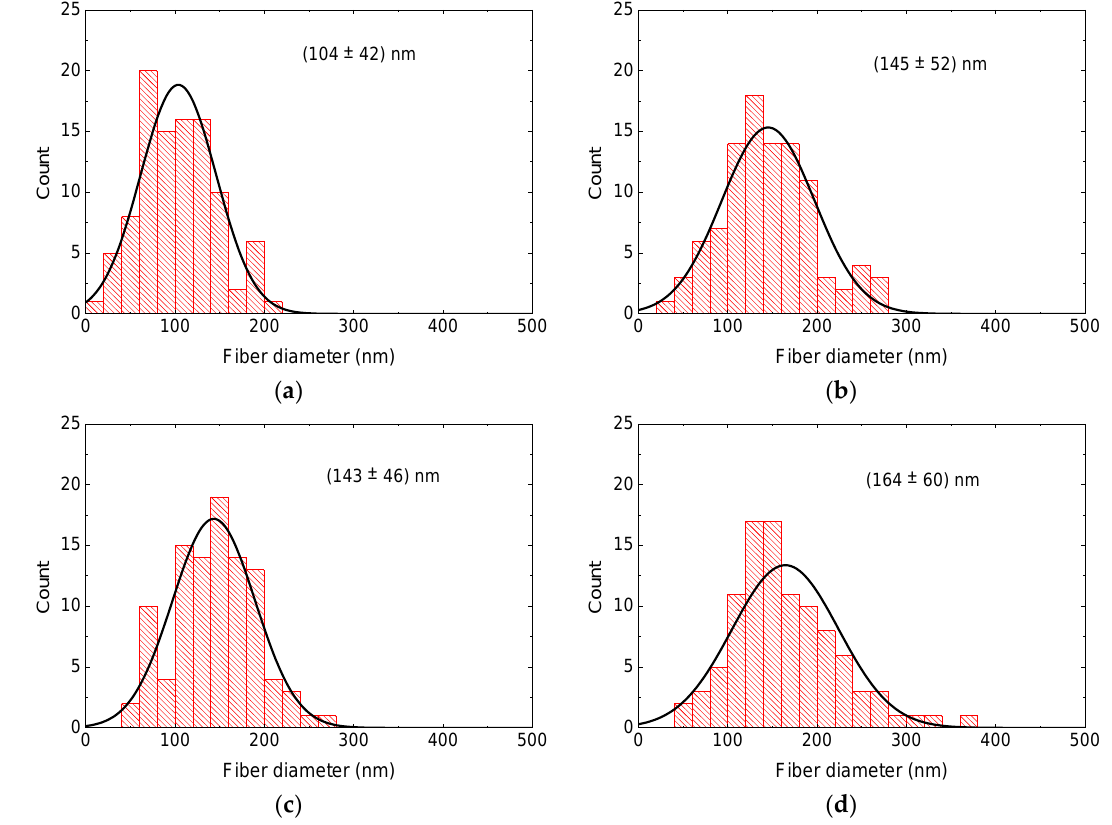
Figure 5. Distributions of the diameters of PAN / nickel-ferrite nanofibers: ( a ) after electrospinning; ( b ) after stabilization; ( c ) after carbonization at 500 °C; ( d ) after carbonization at 800 °C.